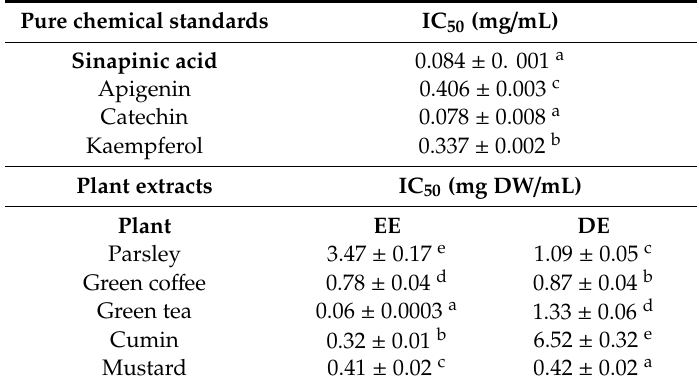
Table 2. Comparison of ABTS radical scavenging ability (expressed as IC 50 values) of pure chemicals, ethanol plant extracts (EEs), and digested plant extracts (DEs) ( n = 9).